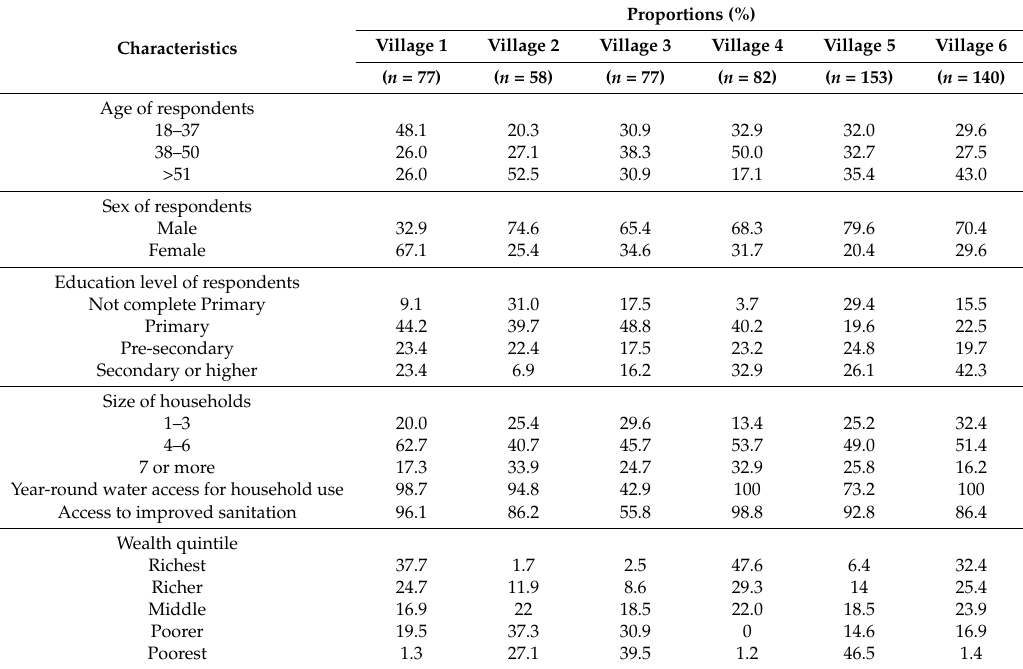
Table 1. Household characteristics in six Open Defecation Free verified